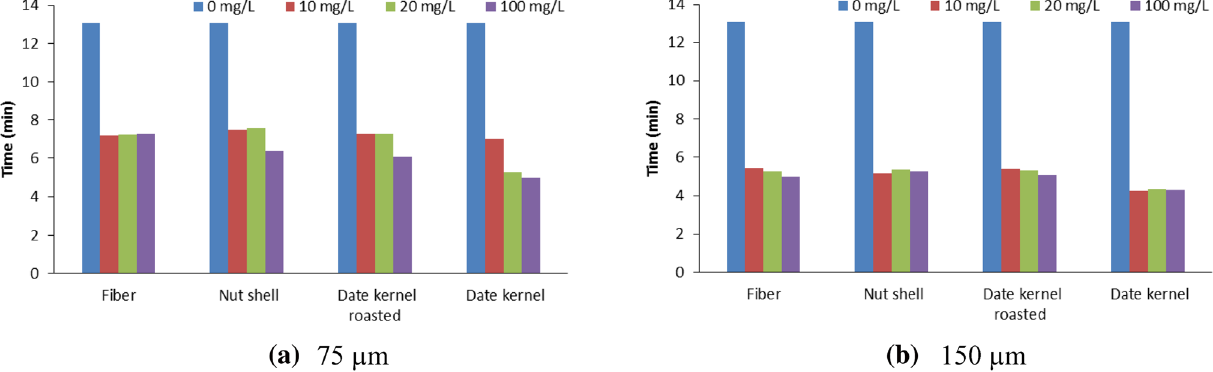
Fig. 10 Flowing time of heavy crude oil using bio